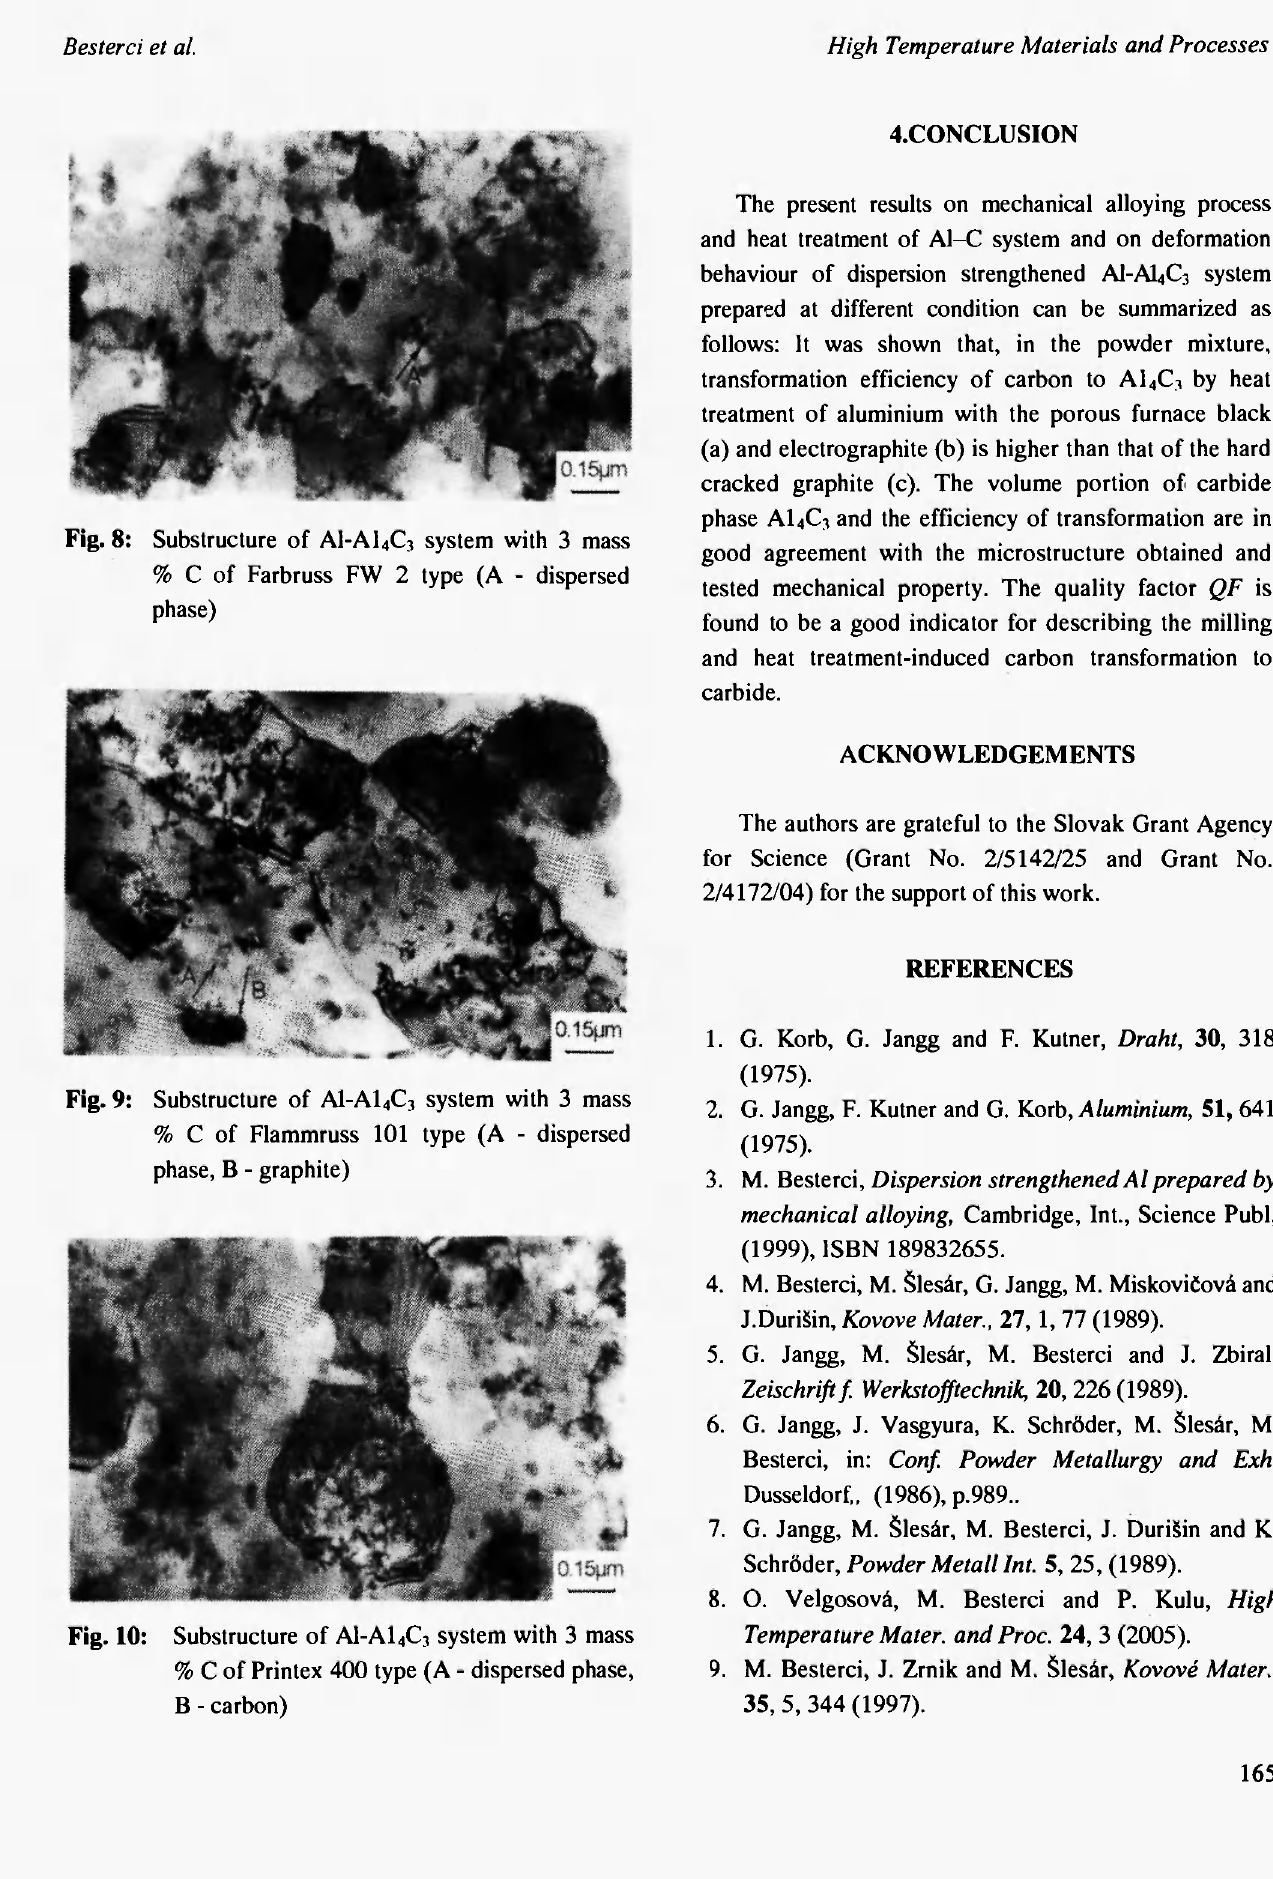
Fig. 8: Substructure of AI-AI4C3 system with 3 mass % C of Farbruss FW 2 type (A - dispersed phase)